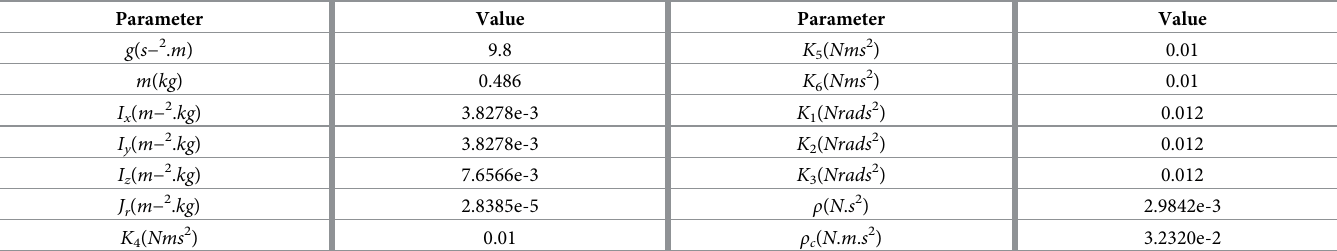
Table 1. Quadrotor parameters.